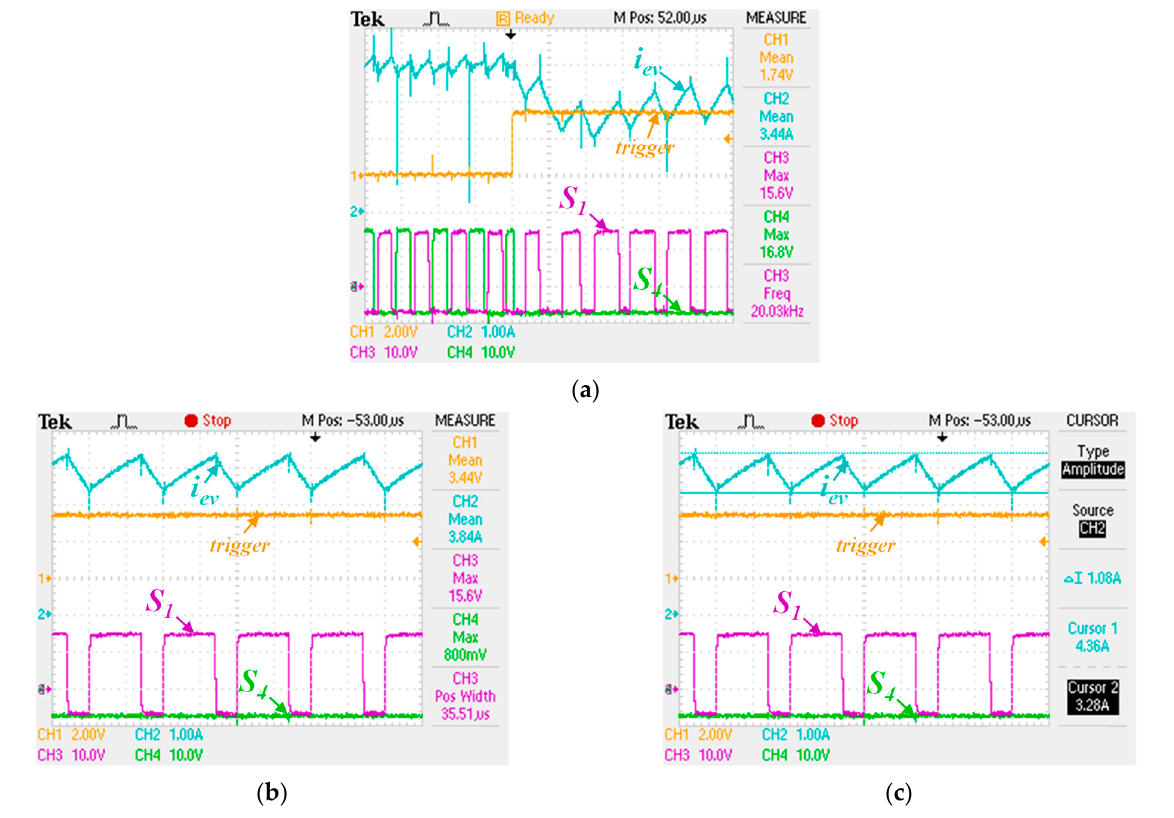
Figure 15. Transient-state operation of the multilevel dc–dc converter following a failure in the negative wire of the bipolar dc grid: ( a ) transition time from normal conditions (trigger value of 0 V) to fault conditions (trigger value of 3.3 V); ( b ) an i ev of 4 A and a duty cycle of 71% for semiconductor S 1 , while that of S 4 equals to 0%; ( c ) an i ev ripple value of 1.08 A.